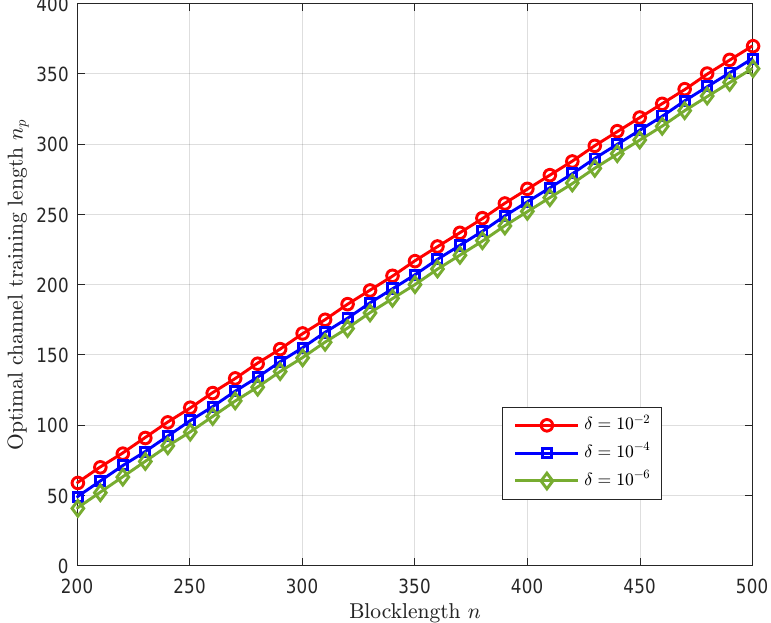
Figure 5. The optimal channel training length n p versus the blocklength n with α = 0.5, ρ = 10 dB, ¯ γ sd = 0 dB, and ¯ γ se = 0 dB, where the optimal channel training length is obtained without reliability